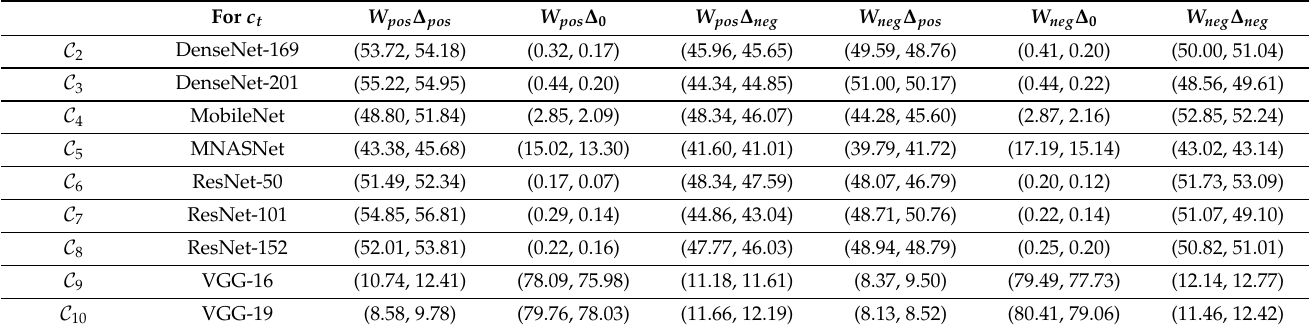
Table A3. For c t , average percentage of both positively related ( W pos , columns 2–4) and negatively related ( W neg , columns 5–7) units in which the activation increased ( ∆ pos ), stagnated ( ∆ 0 ), or decreased ( ∆ neg ). In each row, the respective CNN is only fed with C 1 ’s adversarial images D atk contains the results for EA and